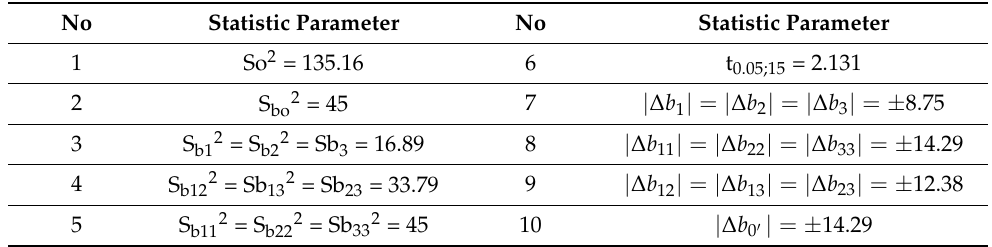
Table 6. Results of the statistical processing of the experimental data referring to 34CrAlMo5 nitralloy steel in nitrogen diluted ammonia atmosphere.